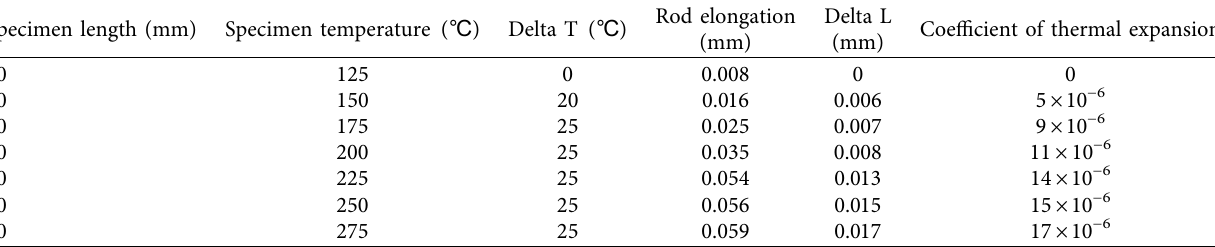
Table 10: CTE of the Ni-Cu alloy+ 3% TiO